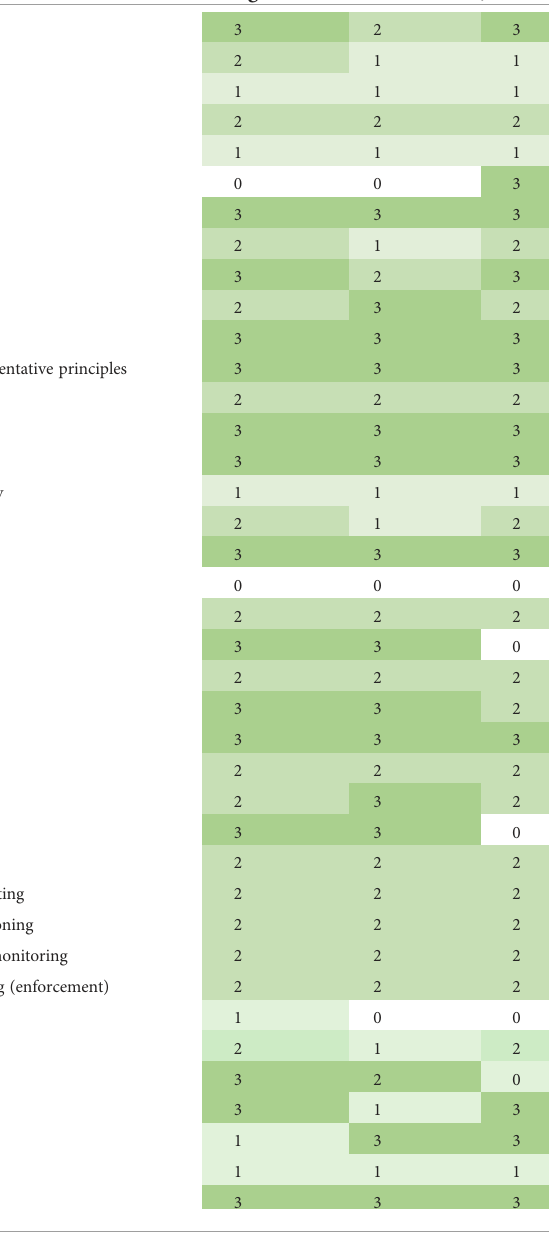
TABLE 2 Evaluation results for Shengsi, Putuo, and Jiushan; bold indicates newly added indicators, italic indicates environmental performances indicators. Type of indicators Attributes of the species or ecosystem within the MPA